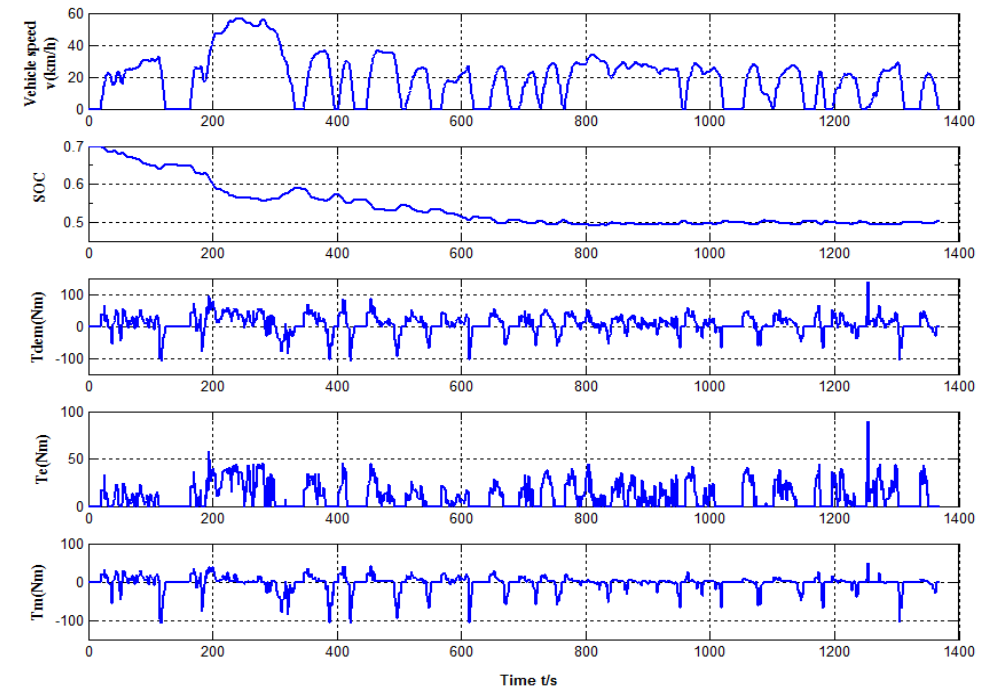
Figure 9. Simulation results under